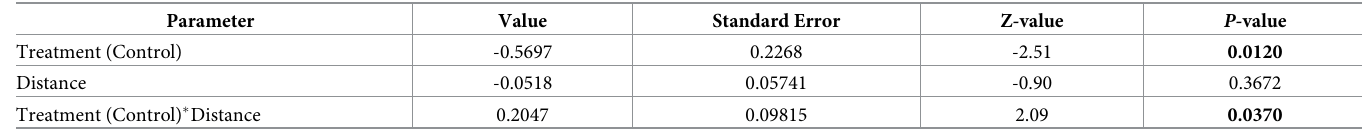
Table 6. Parameters from Cox Proportional Hazards Regression Model affecting Aedes albopictus mortality post-exposure to emanators